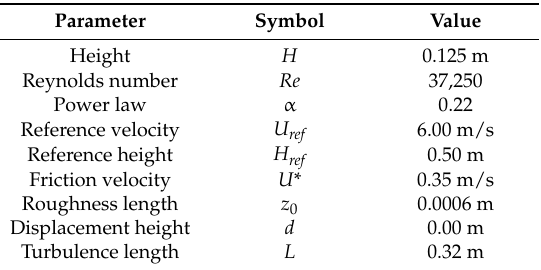
Table 1. Parameters for the scaled model